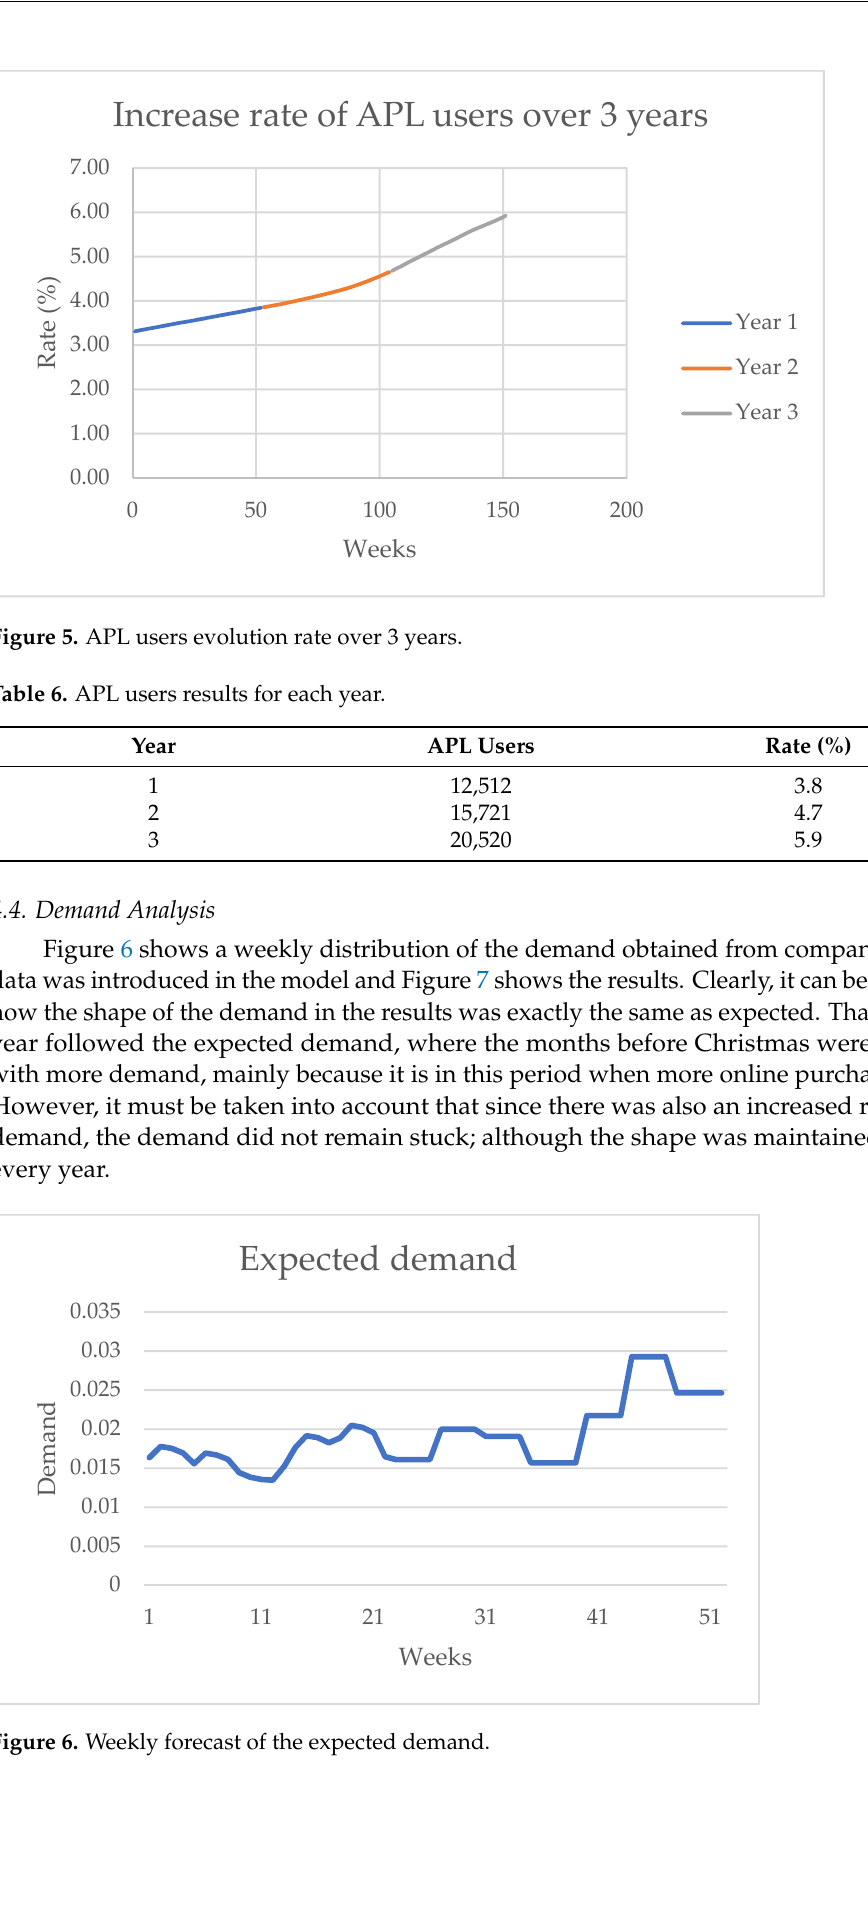
Figure 7. Weekly evolution of the demand over 3 years. 4.5. Year Analysis These results can be analyzed as follows. First, it can be seen that the facility location problem was solved for the first year, with an average of 41 lockers to cover an average demand of 12,931 orders per year. Regarding the opening and closing costs, these were EUR 166,600 and EUR 1280, respectively. Note that the opening costs were high in com- parison with the other years and that was because the simulation started from scratch when lots of APLs needed to be opened. Considering that starting a new locker cost EUR 2450 and decommissioning it cost EUR 80, it could be calculated that in this first year, 68 APLs were installed and 16 were closed, ending the year with 52 lockers. On one hand, the upkeep costs were EUR 330,460, which represented the maintenance costs of the av- erage value of 41 lockers this first year; that is, 155 EUR/locker/week, with 52 weeks the first year. On the other hand, the service costs were 93.37% of the EUR 7,019,279 total costs, which were, by far, the most expensive costs. Table 7 presents overall analysis for each year. Figure 8 shows percentage breakdown of the total costs for the first year (a), percent- age breakdown of the total costs for the second year (b), and percentage breakdown of the total costs for the third year (c).